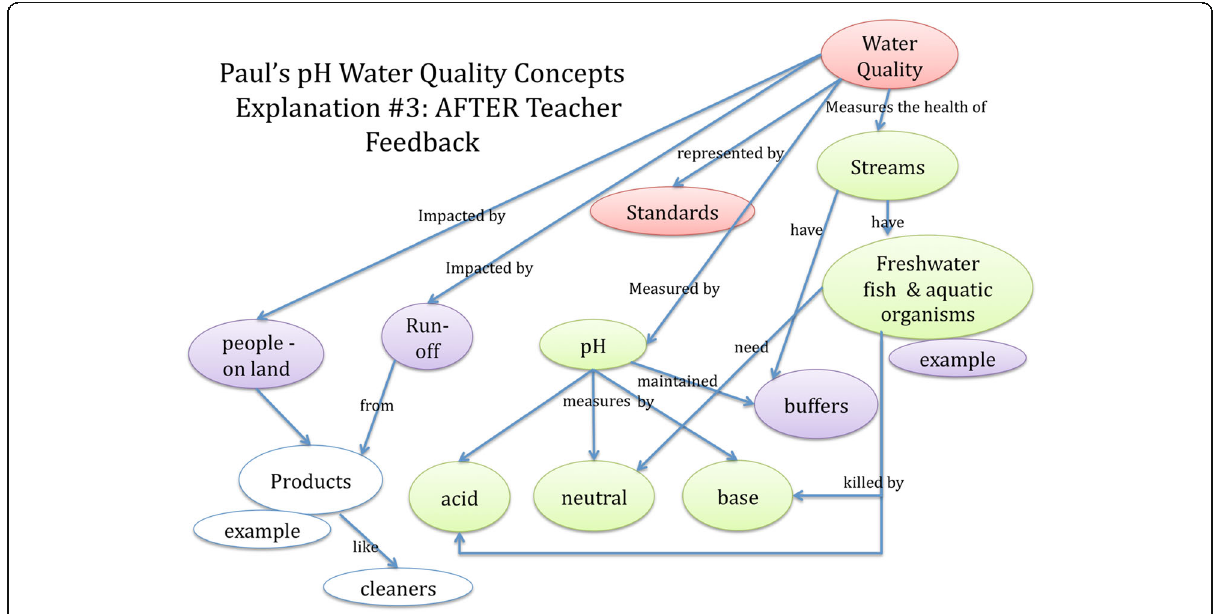
Fig. 4 Paul ’ s Explanation 3 (Ex3): Rubric Score - 5/6